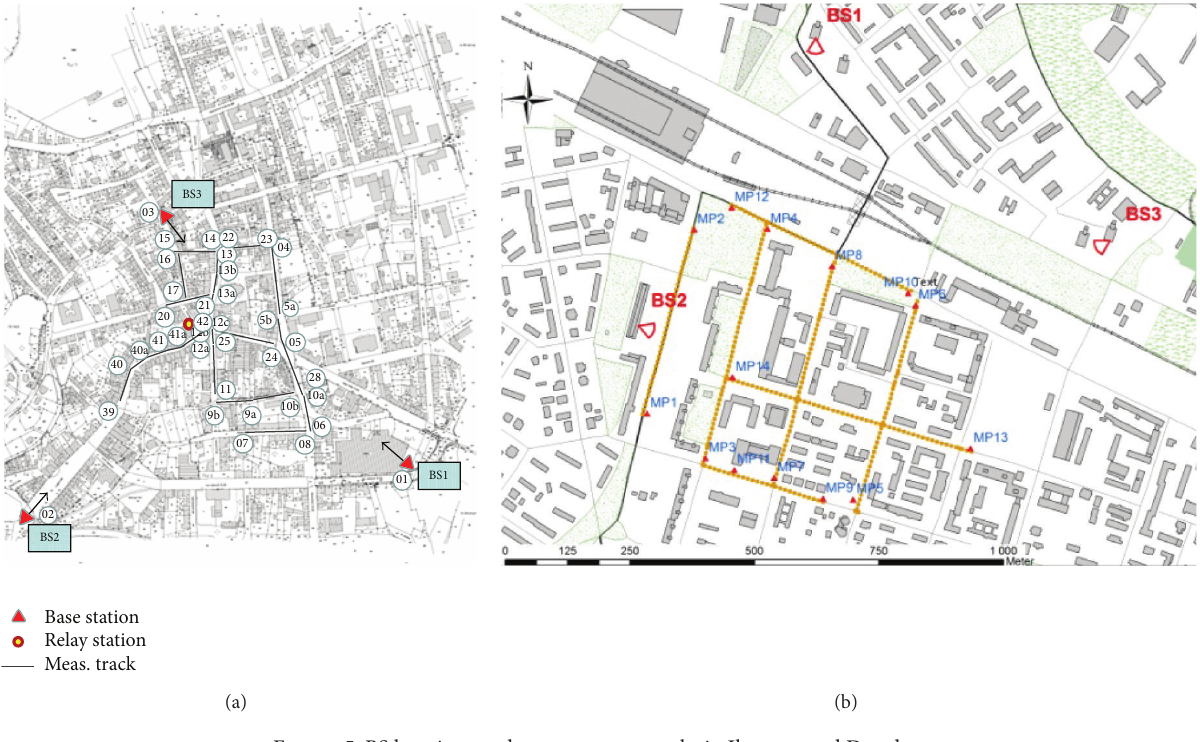
Figure 5: BS locations and measurement tracks in Ilmenau and